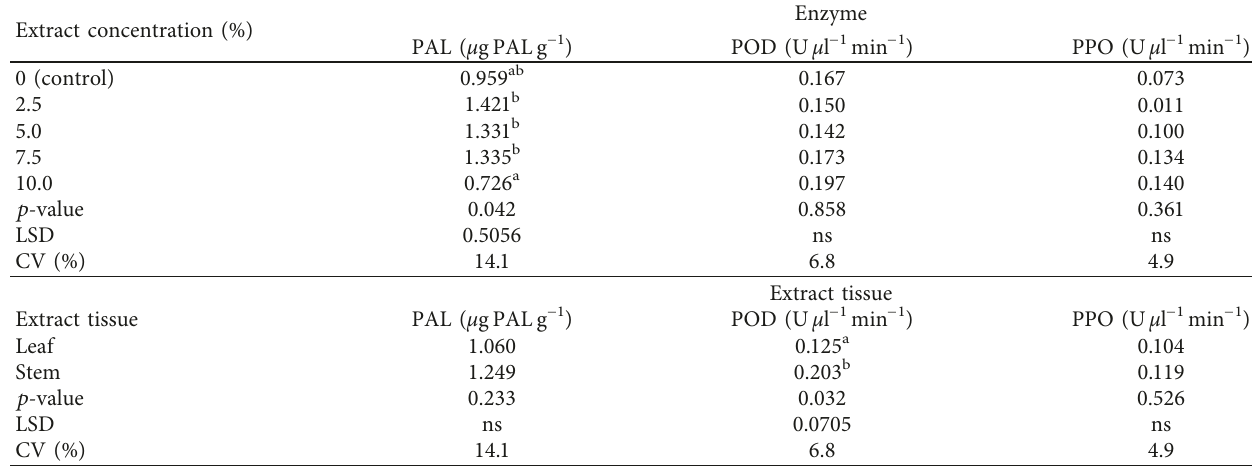
Table 9: Effect of different concentrations of sorghum leaf and stem aqueous extracts on PAL, POD, and PPO activity in goose grass. Extract concentration